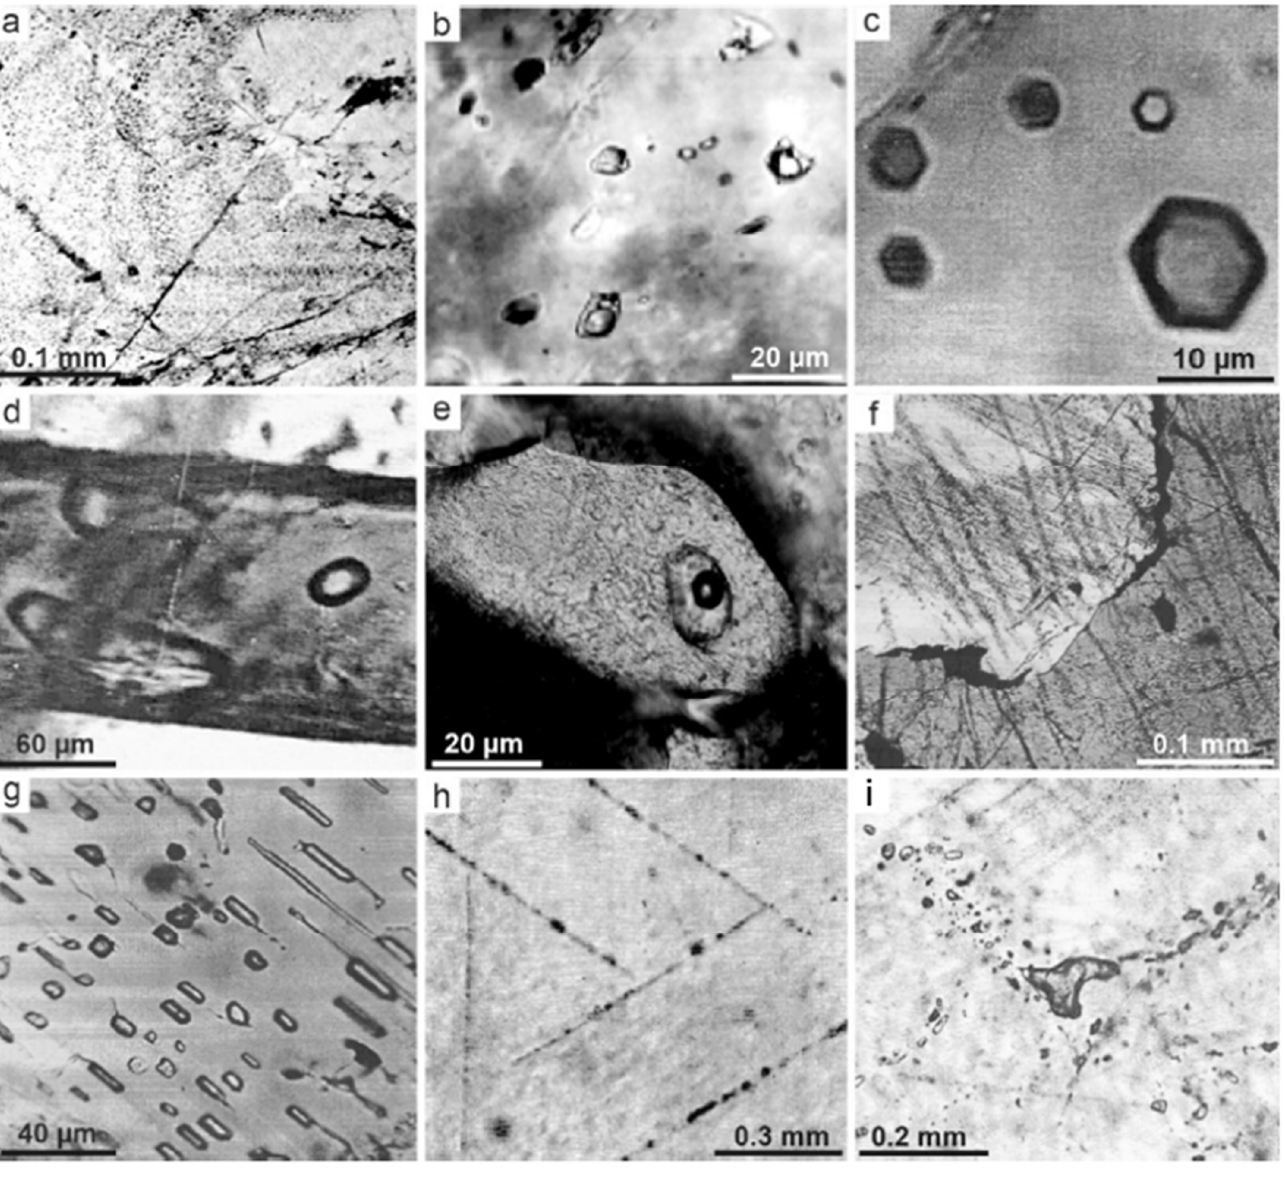
Figure 2. Primary ( a – e ) and secondary ( f – i ) fluid inclusions in the Khibiny minerals: ( a ) gas (hydrocarbon-bearing) inclusions along growth zones; ( b ) two-phase fluid inclusions in the nepheline [62]; gas inclusions in nepheline ( c ) and aegirine ( d ) of the rischorrite; ( e ) gas–liquid inclusion in titanite from the apatite–nepheline ore; ( f , g ) hydrocarbon-bearing fluid (mainly gaseous) inclusions in the nepheline of urtite; ( h , i ) fluid (gas and gas–liquid) hydrocarbon-bearing inclusions in the eudialyte-group mineral [3].